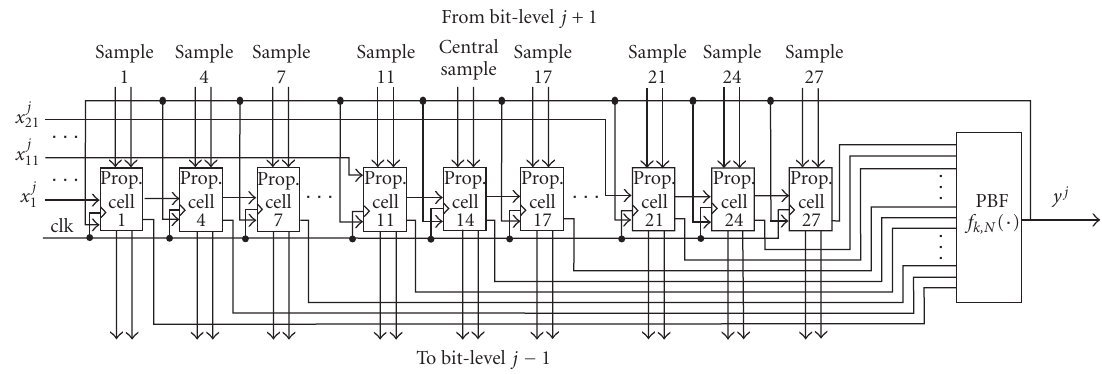
Figure 5: The j th bit plane of the 3D LUM smoother with N = 27.